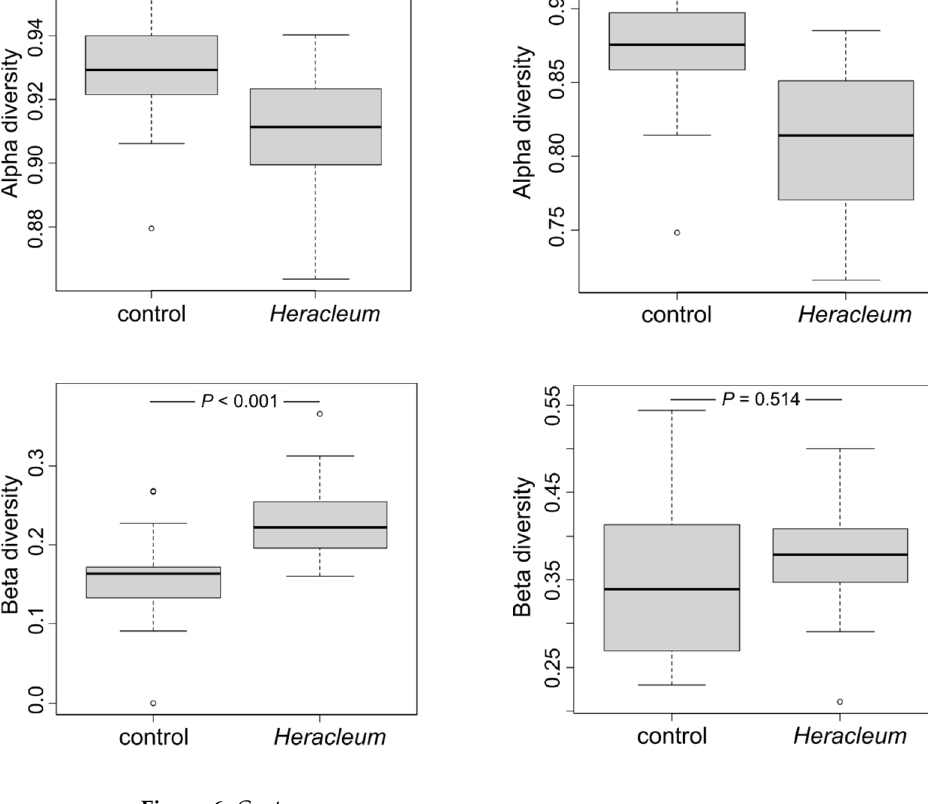
Figure 6. Boxplots showing differences in diversities between control and Heracleum sites (N = 38) in forest birds (left side) and non-forest birds (right side); FD—functional diversity.